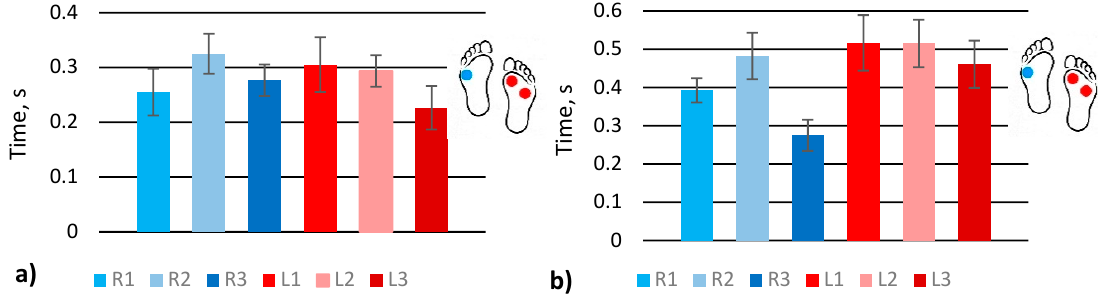
Figure 6. Analysis of stepping abruptness at various gaits: ( a ) scrolling; ( b ) walk with one straight leg.